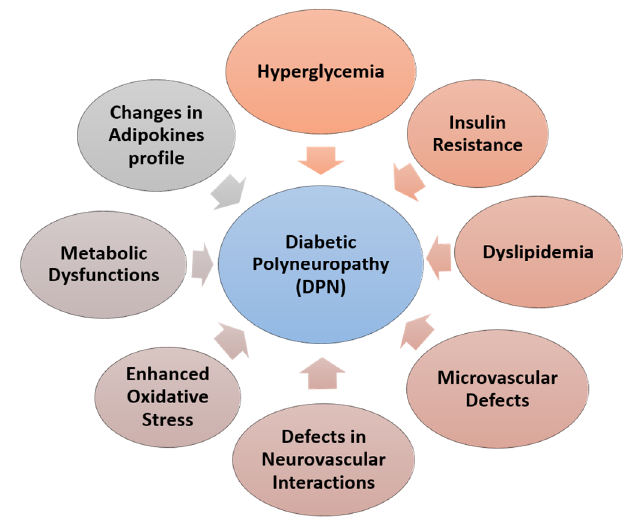
Figure 1. Factors responsible for diabetic polyneuropathy (DPN).